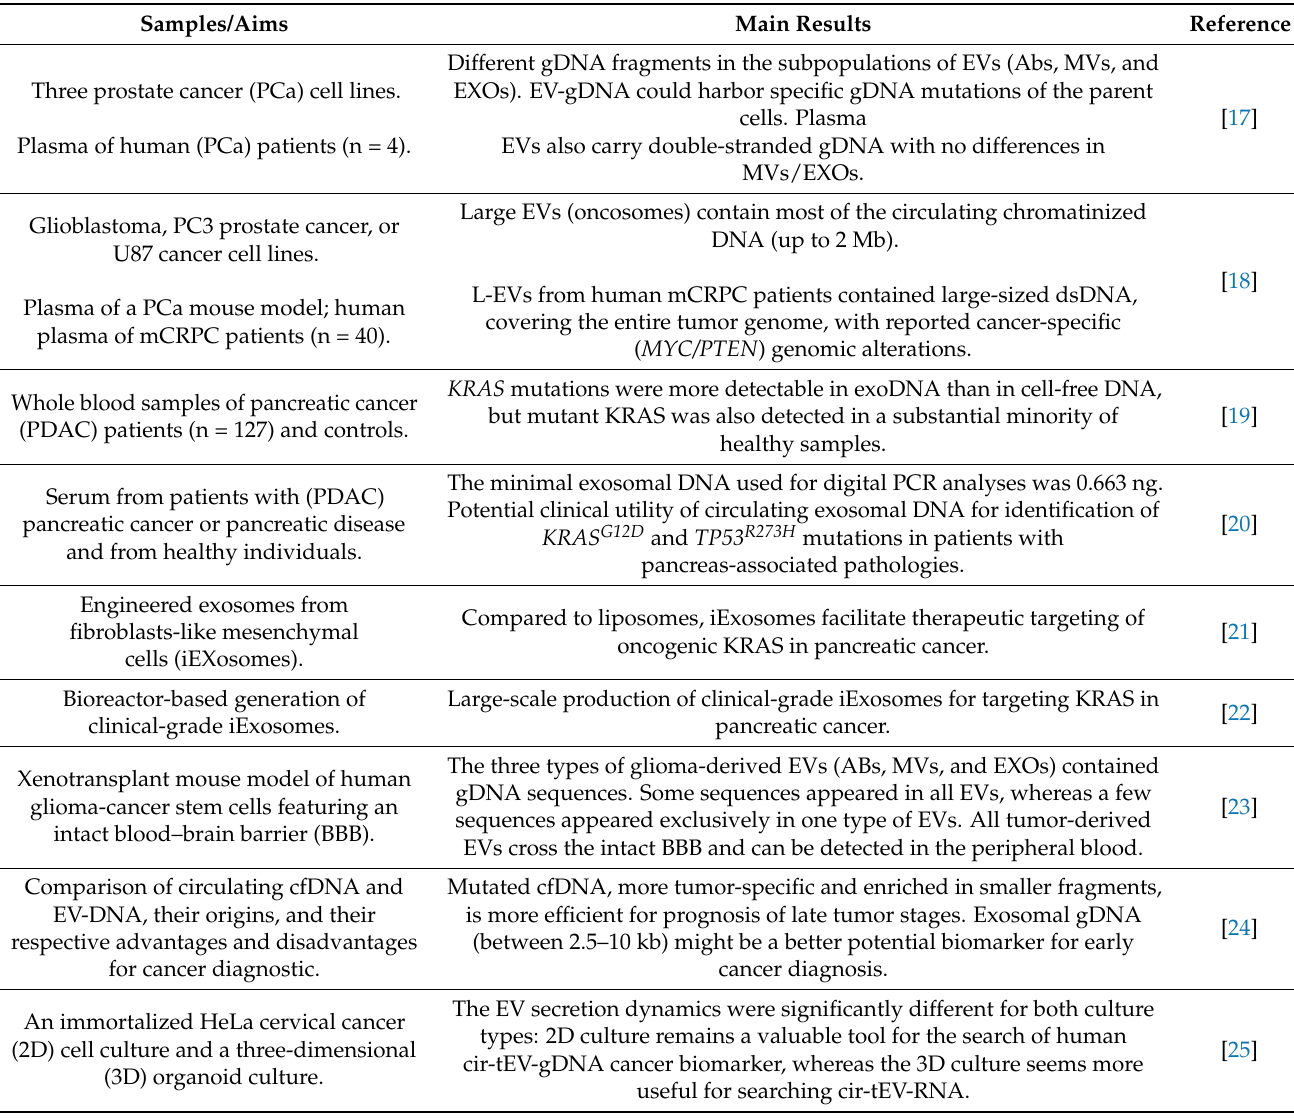
Table 2. Further studies on circulating tumor EVs-DNAs